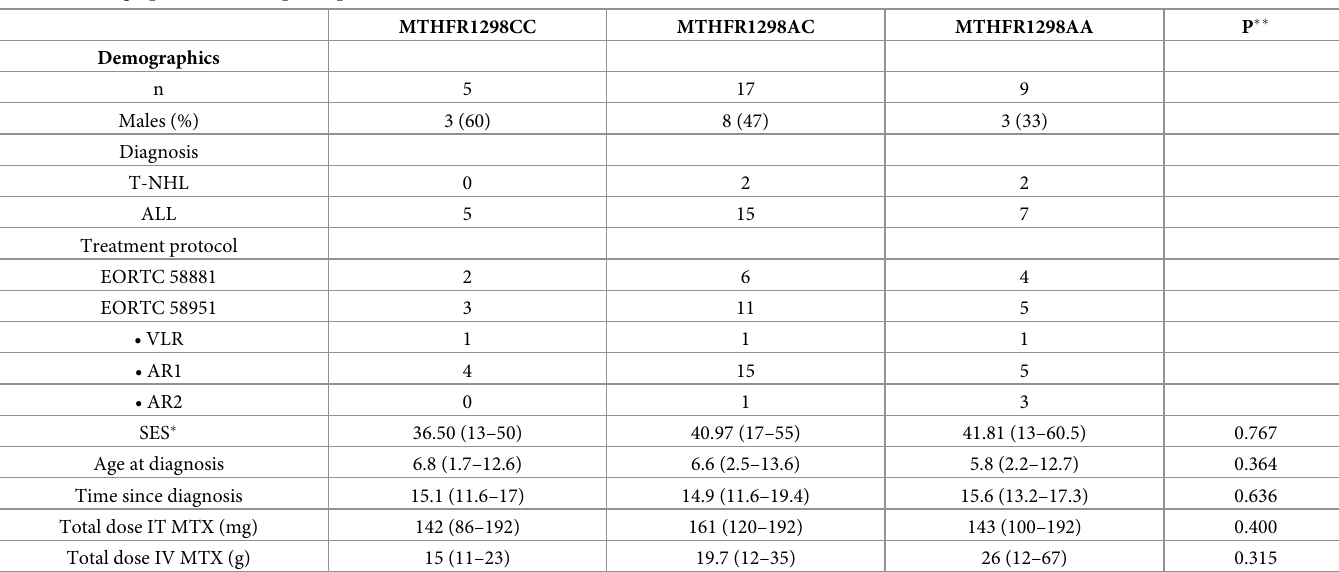
Table 1. Demographic data of the